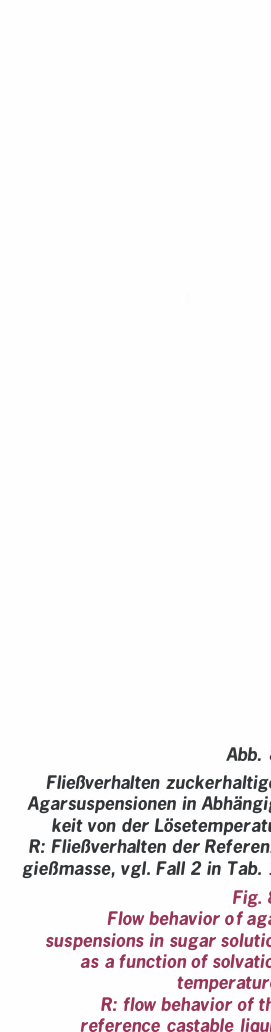
Fig. 8: Flow behavior of agar suspensions in sugar solution as a function of solvation temperature.